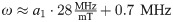
Hyperfine interactions impact the singlet product probability change in the studied model reaction.The strength of the isotropic hyperfine coupling constant a1 is modified here. Pronounced changes in the singlet probability are always seen in the low-frequency limit, and for ω≈a1·28MHzmT+0.7MHz. The fixed hyperfine coupling, a2, gives rise to a singlet probability change around 28.7 MHz and enhances the singlet probability change at 28.7 MHz when a1 = 1.00 mT. kS = kT = 106 s−1, B0 = 50 μT and B1 = 50 μT are assumed in all calculations.